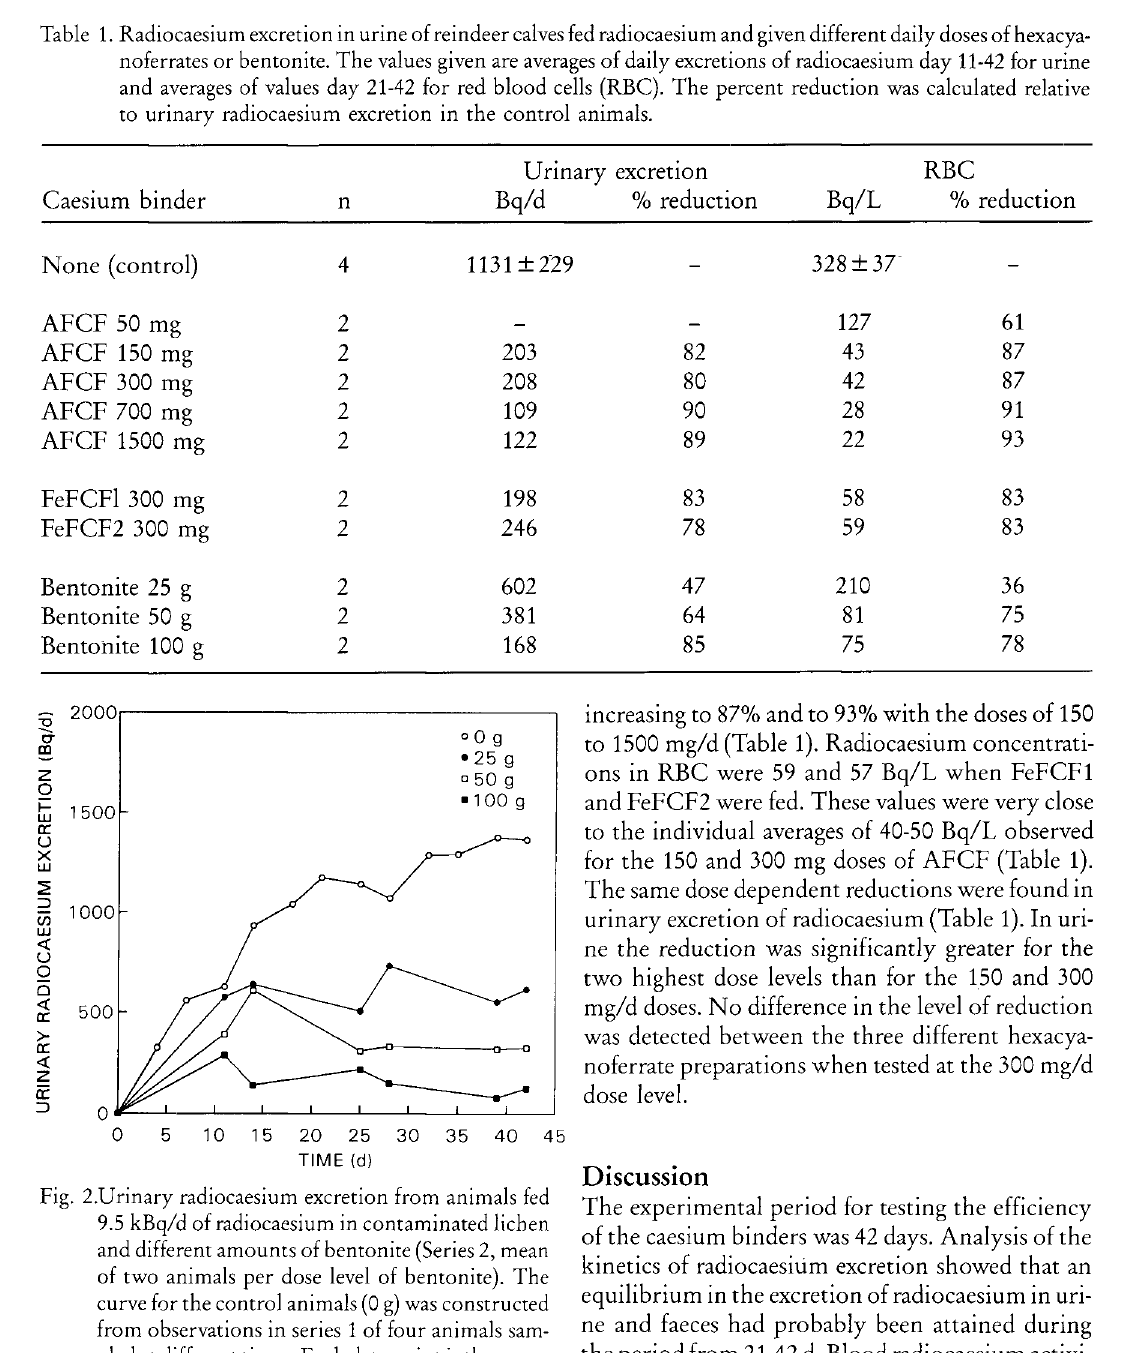
Fig. 2.Urinary radiocaesium excretion from animals fed 9.5 kBq/d of radiocaesium in contaminated lichen and different amounts of bentonite (Series 2, mean of two animals per dose level of bentonite). The curve for the control animals (0 g) was constructed from observations in series 1 of four animals sam pled at different times. Each data point is the avera ge of observations from two